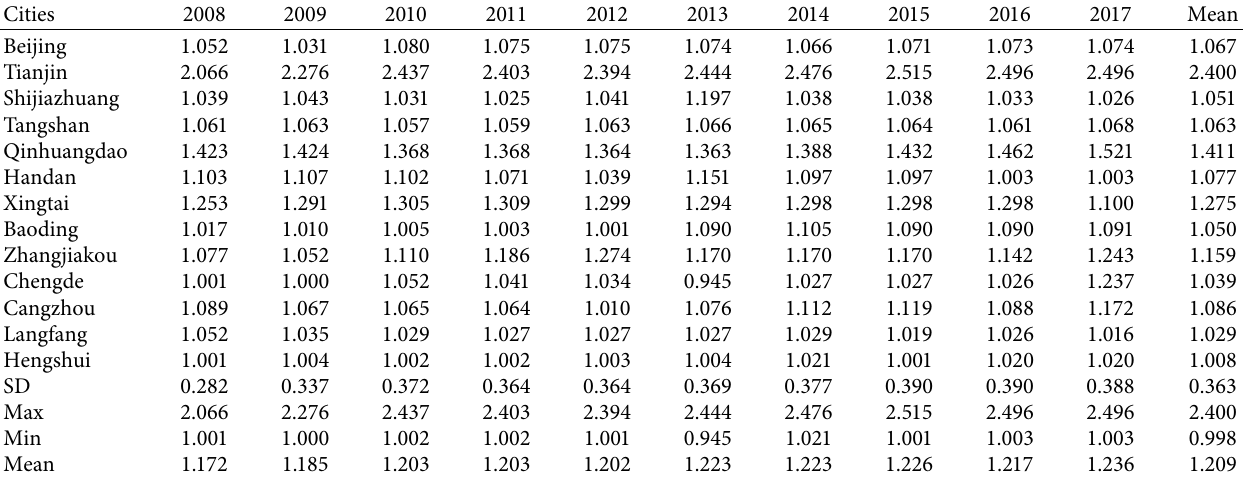
Table 2: Calculation results of the primacy of Beijing-Tianjin-Hebei urban agglomeration.